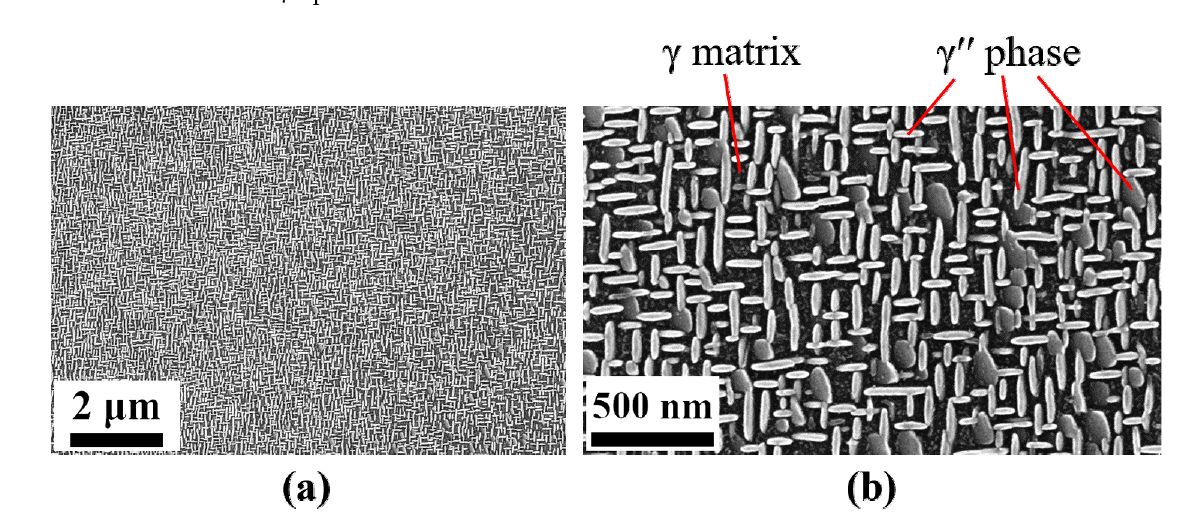
Figure 2. Example SEM images in the interdendritic region from the single crystalline 718M sample after heat treatment. All three orientation variants of the γ (cid:48)(cid:48) particles precipitates contribute to the